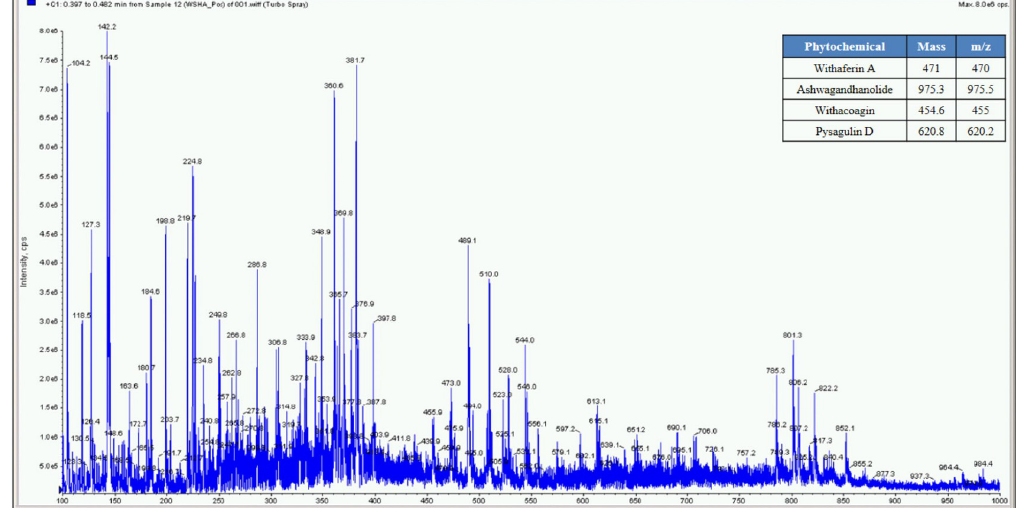
Fig 5. Mass spectrometer fingerprinting of Withania somnifera hydro-alcoholic extract (WSHA).